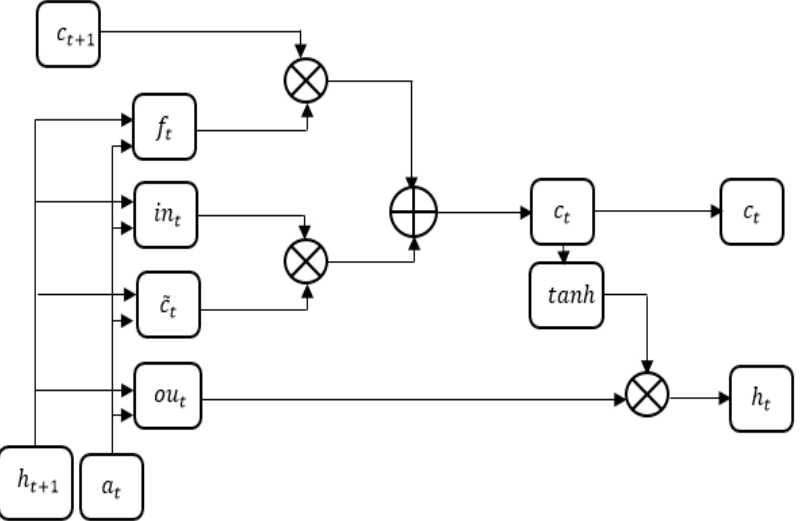
Figure 5. Graphical presentation of the LSTM unit.